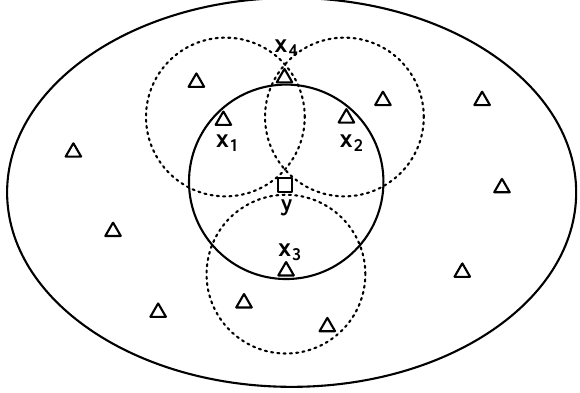
Figure 2. Illustration of dependence among edited training